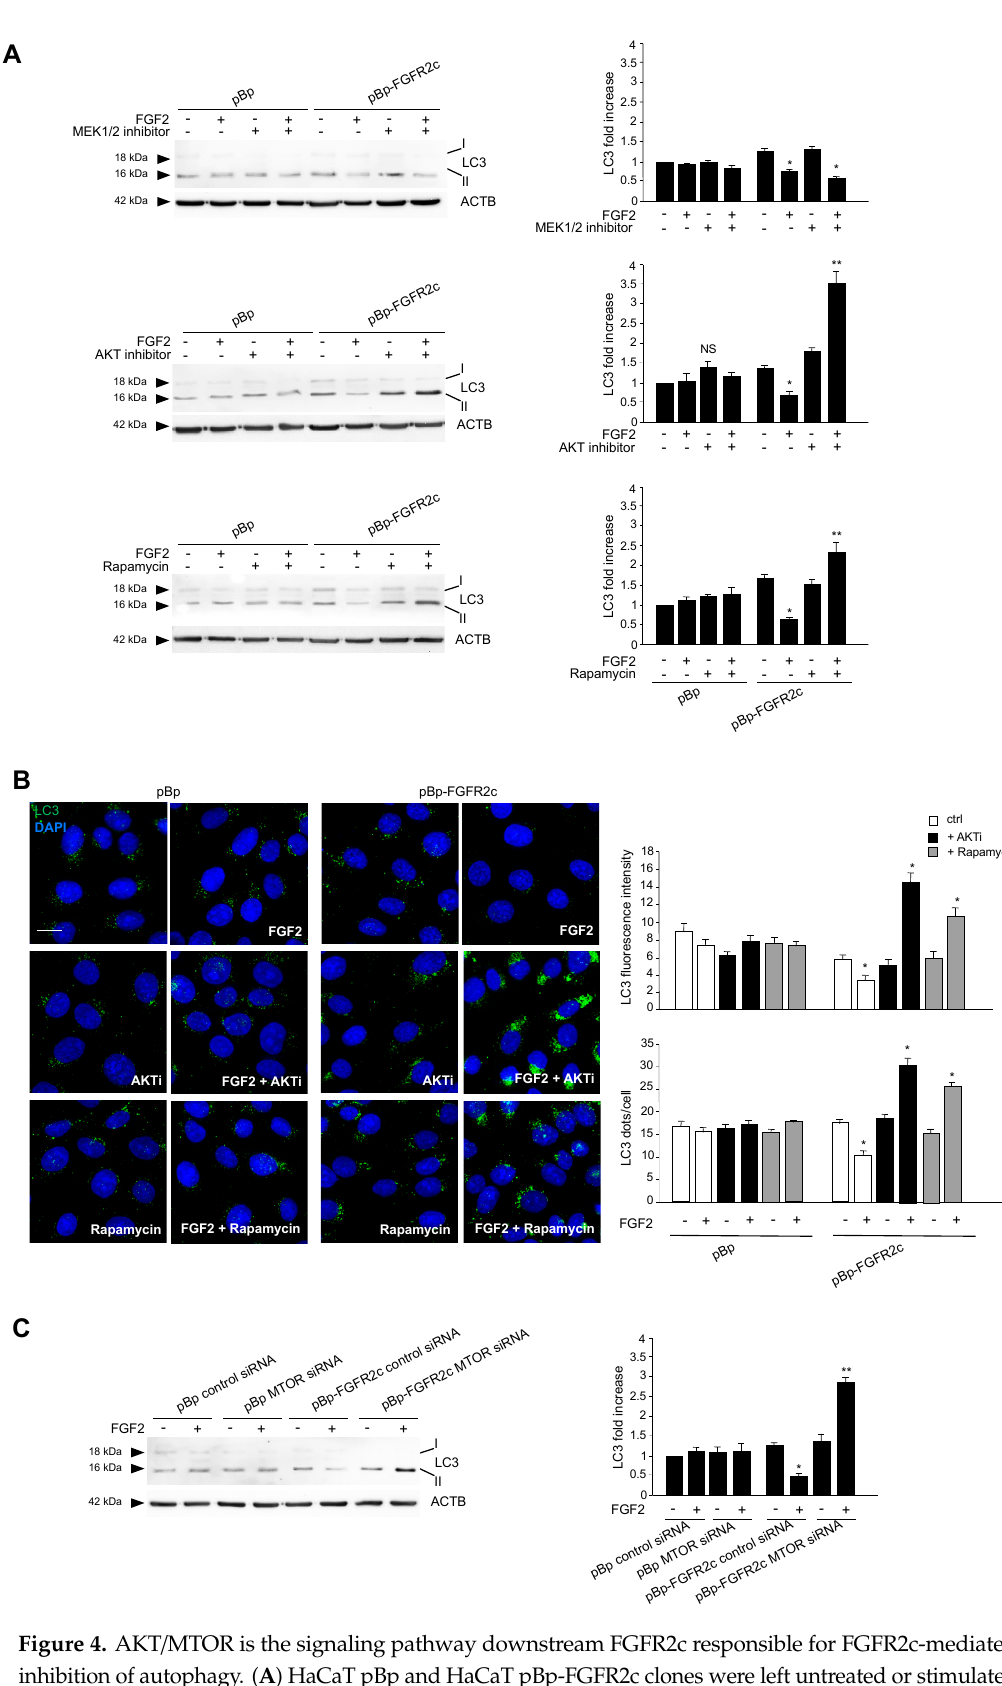
Figure 4. AKT/MTOR is the signaling pathway downstream FGFR2c responsible for FGFR2c-mediated inhibition of autophagy. ( A ) HaCaT pBp and HaCaT pBp-FGFR2c clones were left untreated or stimulated with FGF2 in the presence or absence of the indicated substrate inhibitors as reported in Materials and Methods. Western blot analysis shows that both AKT inhibitor and rapamycin increased the level of LC3-II upon FGF2 stimulation in pBp-FGFR2c cells compared to the corresponding